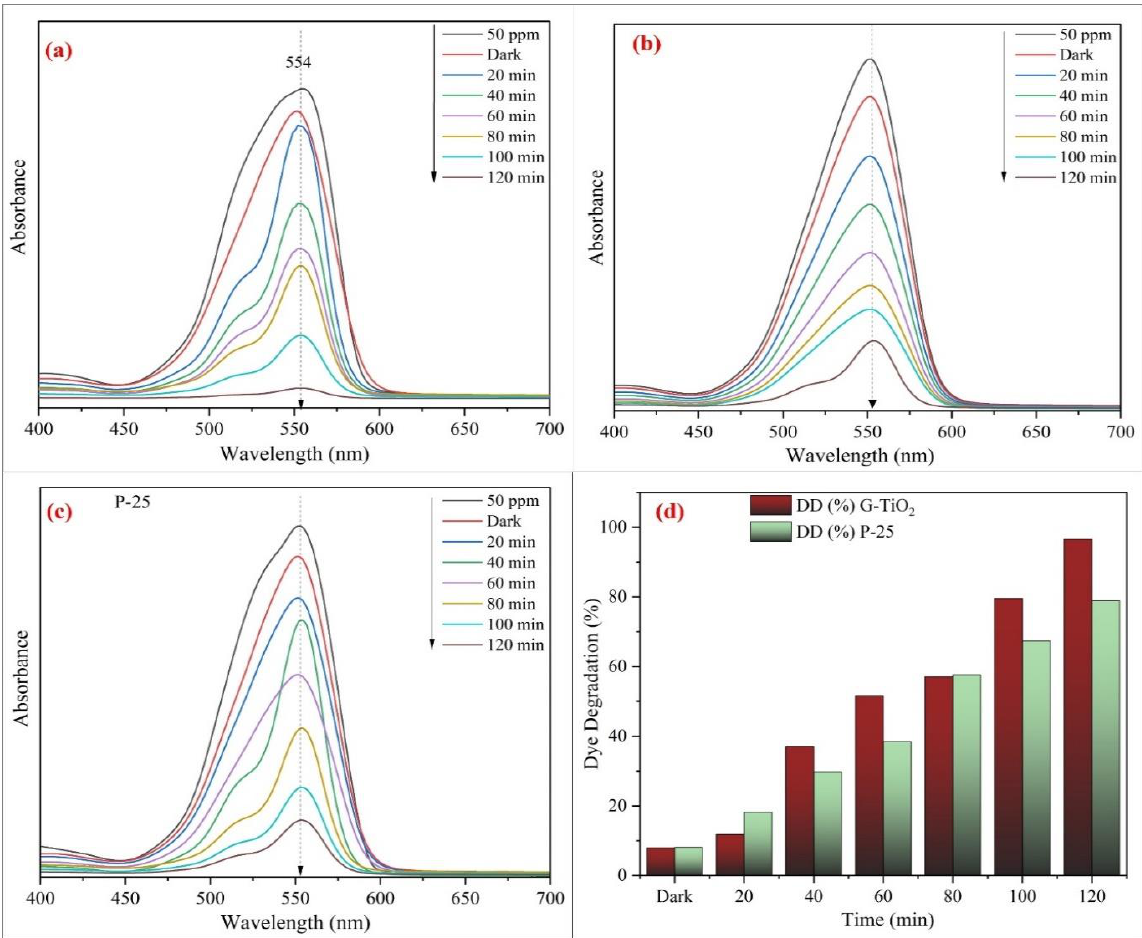
Figure 8. UV-visible absorbance graph to evaluate RhB dye degradation with ( a ) biosynthesized TiO 2 ; ( b ) bare TiO 2 ; ( c ) commercial P-25 nanoparticles; ( d ) degree of degradation.